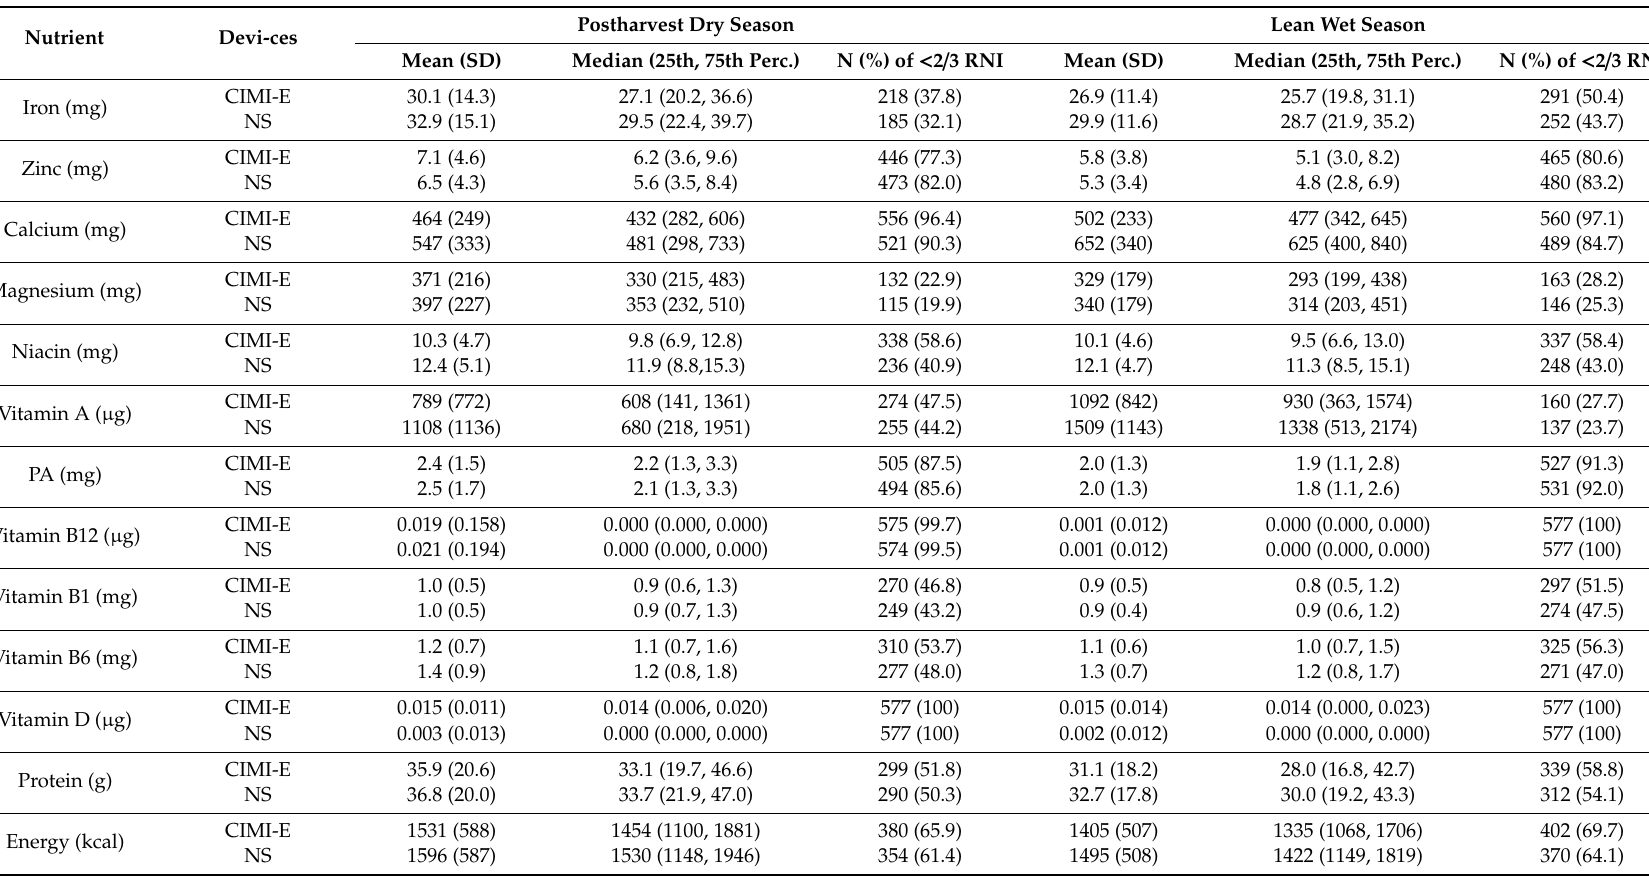
Table 2. Mean (SD), median (25th, 75th percentile), and number (percent) of participants below the threshold of an inadequate nutrient intake ( < 2 / 3 RNI) (N = 577).